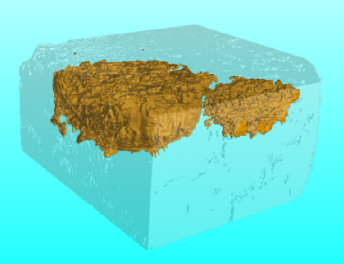
Figure 9. 3D-reconstructed for the coating specimen of the Figure 7a.